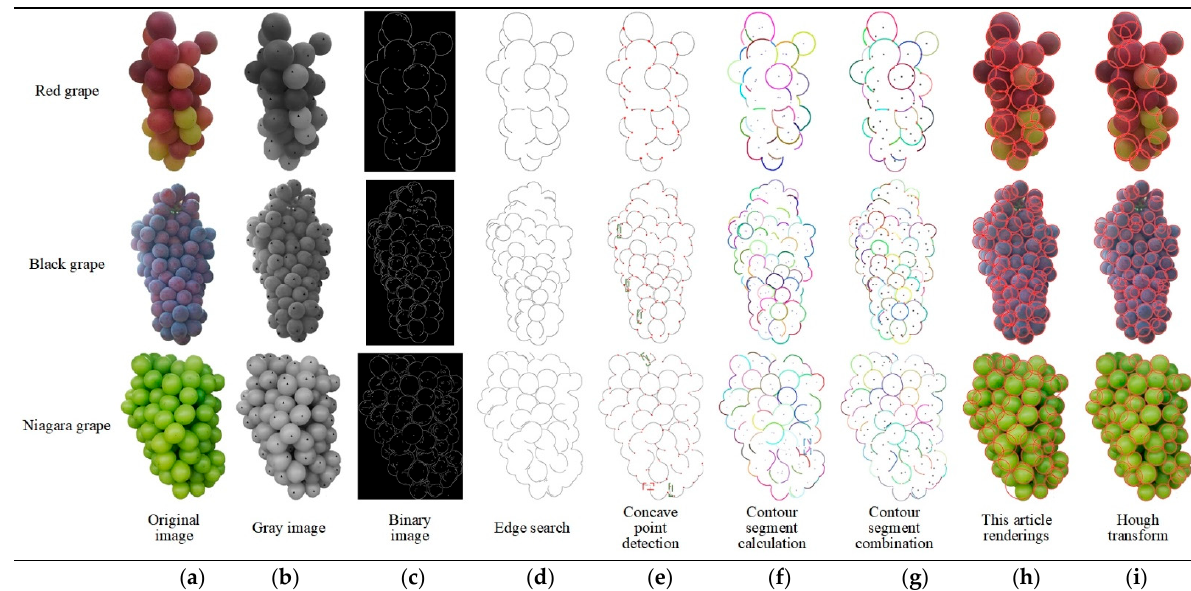
Figure 10. Model detection effect and comparison diagram under different types of grapes. ( b ), “·”represents the point of interest of the fruit; The green dashed frame and the red dashed frame of ( e ) respectively represent the noise and undetected pits that are mistaken for the edge of the grape, and the red dots indicate the position of the detected pits; The blue dashed box in ( f ) indicates the position of the edge arc segment with too little information, the blue dot indicates the position of the centroid point calculated by the contour segment, and the contour segments of different colors indicate different segmented contour segments; The contour segments of different colors in ( g ) represent the contours of different groups of fruit grains, and “·” represents the position of the center point calculated for each group of contour segments; The red circles in ( h , i ) respectively represent the particles detected by the method in this paper and the particles detected by the Hough transform.